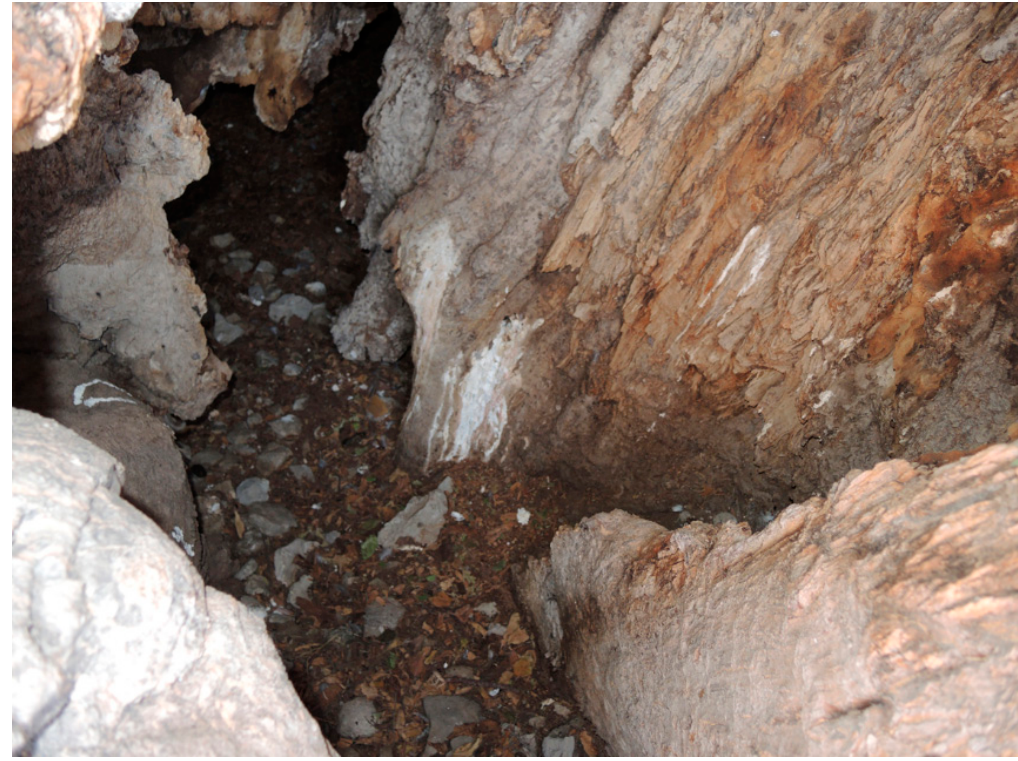
Figure 6. View of the large inner cavity, which consisted mainly of rotten and burned wood.